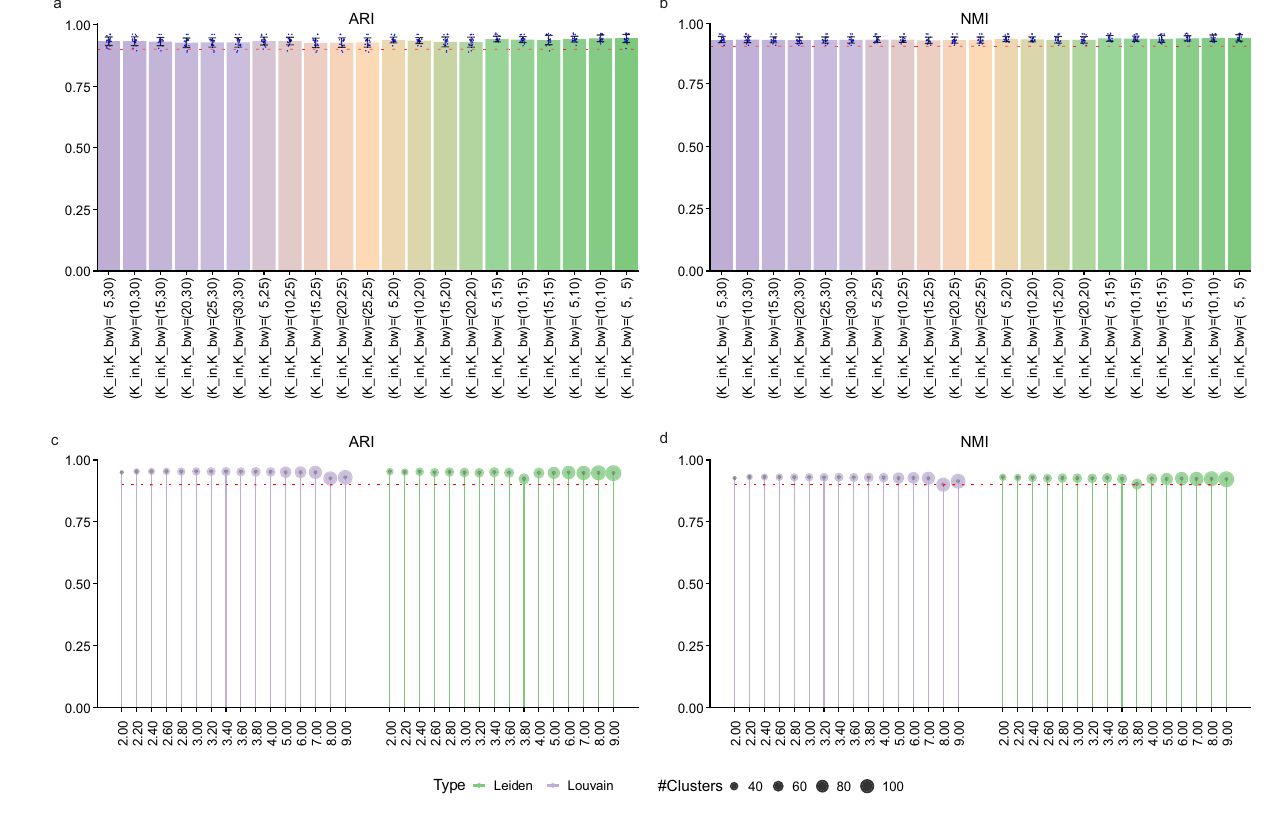
deviation (Data are presented as mean values±SEM). The ARI ( c ) and NMI ( d ), respectively using Louvain and Leiden as the initial clustering method by fi xing (K_bw, K_in)=(10, 5). The resolution is increased from 2.0 to 9.0. the point size means the number of initial clusters and the point height means the value of ARI and NMI. The red dashed line is the 0.9 level line for reference. Source data are provided as a Source Data fi